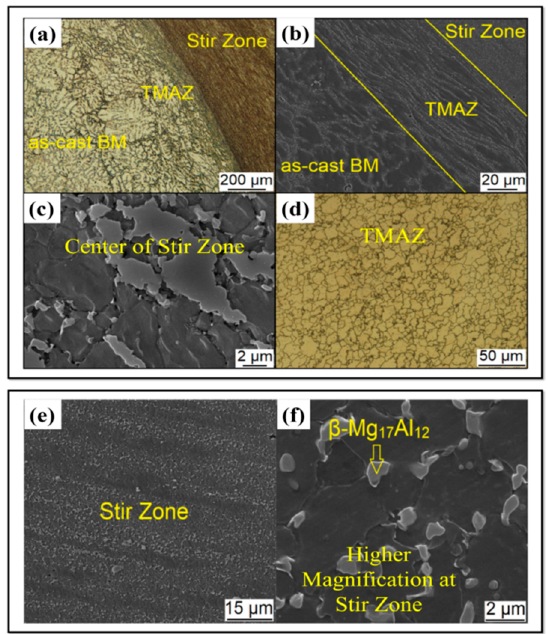
Figure 9. Microstructure of AZ91 alloy friction stir processed: ( a ) OM image of various zones, ( b ) SEM image of various zones, ( c ) SEM image of center of SZ, ( d ) OM image of TMAZ, and ( e , f ) SEM images of SZ at higher magnification (Reprinted with permission from ref. [15]. Copyright 2020 Elsevier